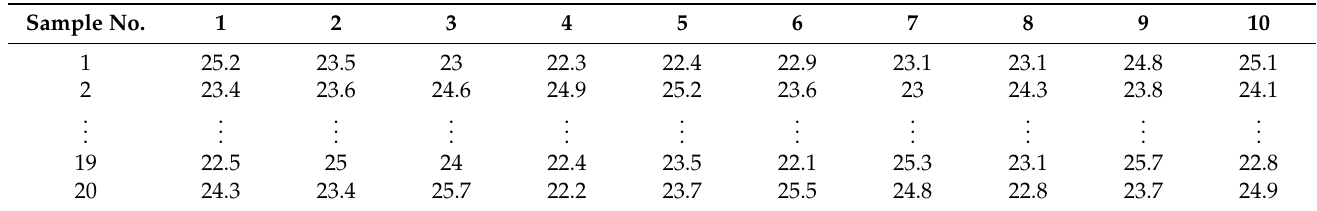
Table 2. Samples of the temperature response ( º C).